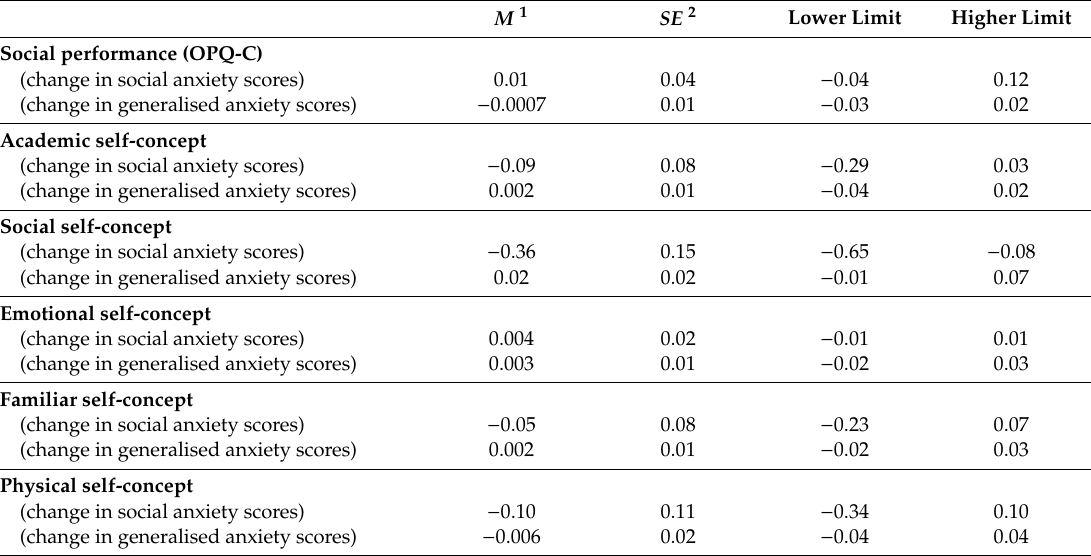
Table 4. Results of confidence intervals for mediating e ff